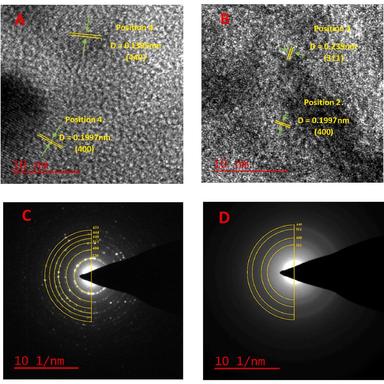
The HRTM lattice fringe image of (A) γAl2O3 and (B) Ti-γAl2O3 materials, and SAED pattern of (C) γAl2O3 and (D) Ti-γAl2O3 materials.